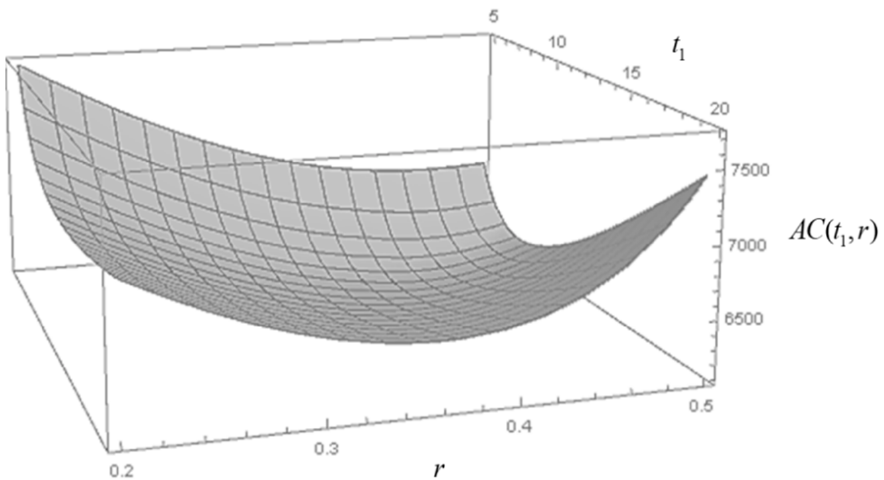
( , ) AC t r with t and r . Figure 5. Graphical illustration of the total cost per unit time AC ( t 1 , r ) with t 1 and r 1 1